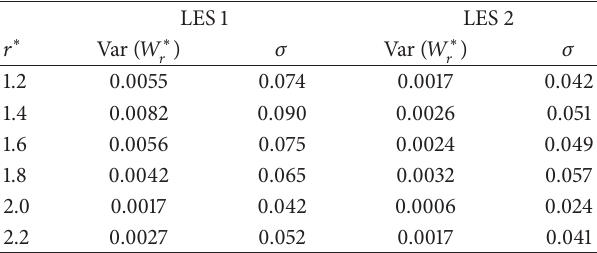
Figure 11: Radial component of the ensemble-averaged mean velocity at 𝑟 ∗ = 2.2 . Table 1: Mean variance value between LDA data of the mean ensemble-averaged radial velocity component and profiles obtained from CFD in dimensionless form.